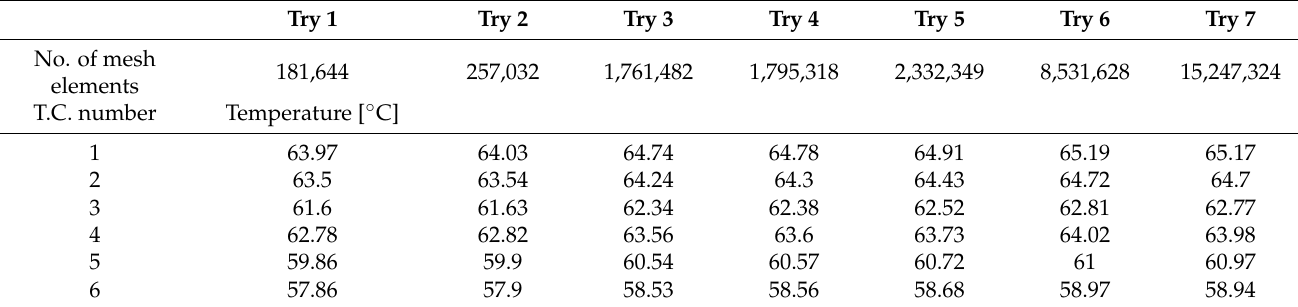
Table 4. Simulations temperatures in mesh independent model